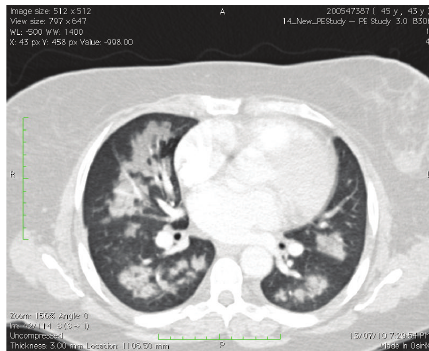
Figure 2: Low power magnification of hematoxylin and eosin stained lung biopsy demonstrating a pauci-immune small vessel vasculitis.